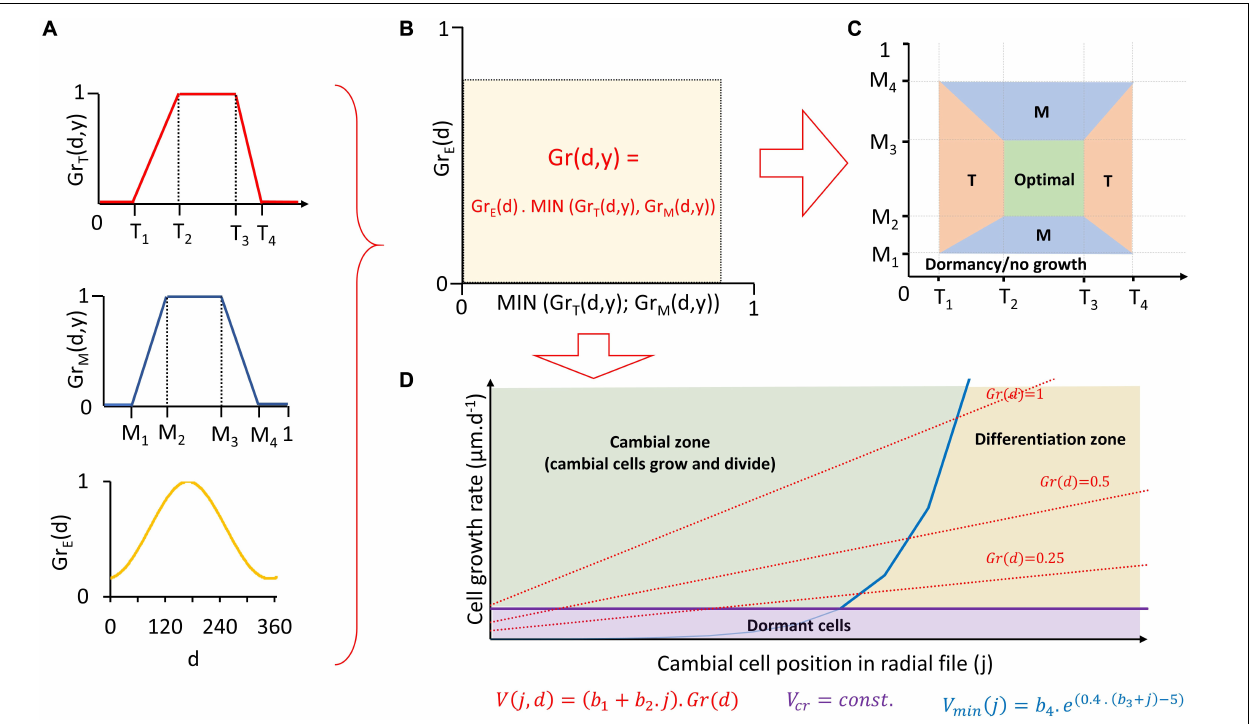
FIGURE 2 | Visual representation of individual steps of Vaganov-Shashkin process-based model in environmental block (A–C) and cambial block (D) . Estimation of daily partial growth rates based on temperature, moisture, and daylength (A) and their conversion into daily integral growth rate (B) . Assessment of dominant climatic growth-limiting factor for each day (C) and calculation of position specific daily growth rates of cambial cells and assessment of their daily fate (growth and division, differentiation or dormancy) (D) . T = temperature; M = moisture; T 1 ... 4 , M 1 ... 4 = threshold temperatures/moisture defining non-linear shape of partial growth rates response to climatic variable; Gr T (d,y), Gr M (d,y) = daily partial growth rates to temperature/moisture; Gr E (d) = daily daylength to daylength of summer solstice; Gr(d,y) = daily integral growth rate; V(j,d) = daily position-specific cell growth rate; V min (j) = growth rate determining transition from cambial zone to differentiation zone; b 1 - 4 , V cr = constants of cambial block; d = day; y = year; j = position of cell in radial